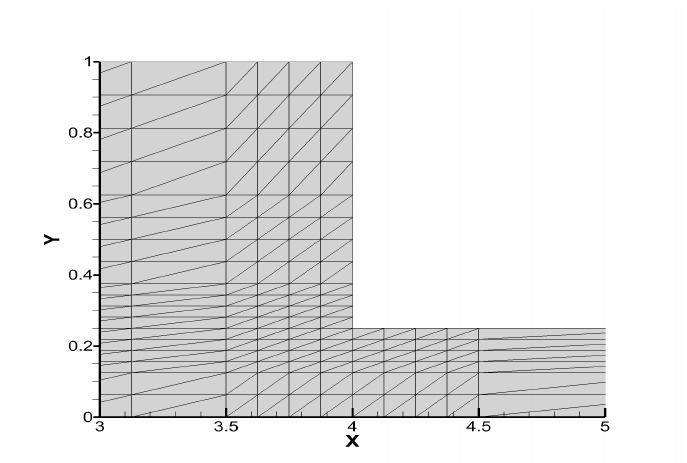
Figure 4. The 4-to-1 contraction computational domain with a typical